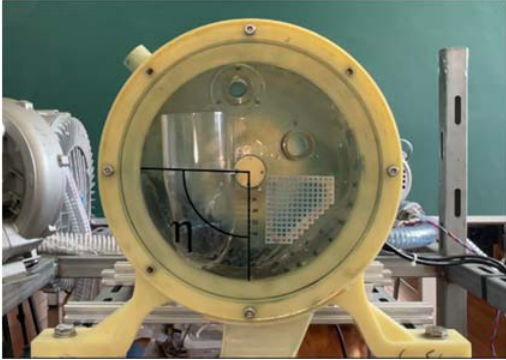
Figure 12. Physical test of seed ‐ metering device. Note: η is the filling angle of cotton seeds, (°).